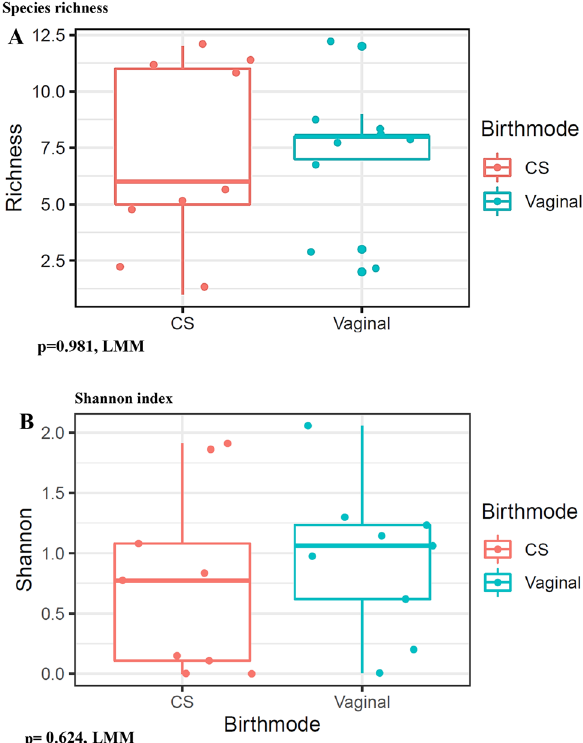
Figure 8. Relationship between postpartum microbiota and delivery mode. (A) Box plot show no significant evidence for impact of delivery mode on microbiome (p richness = 0.981, LMM), (p shannon = 0.624,